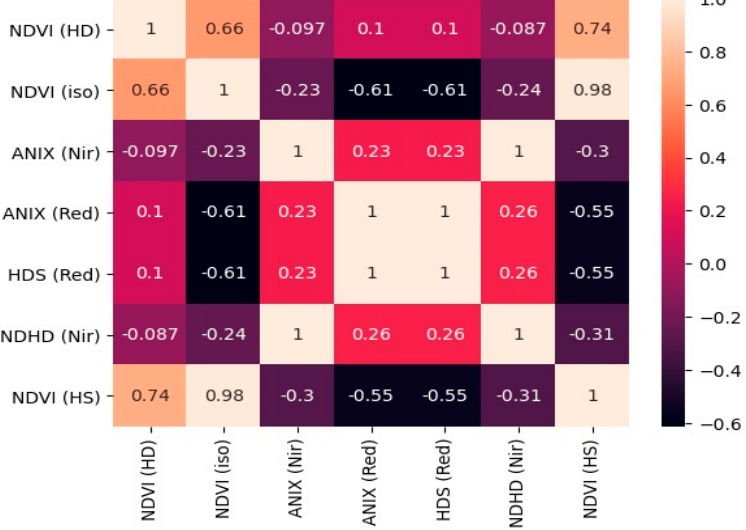
Figure 3. Correlation matrix of the extant multi-angular vegetation indices.